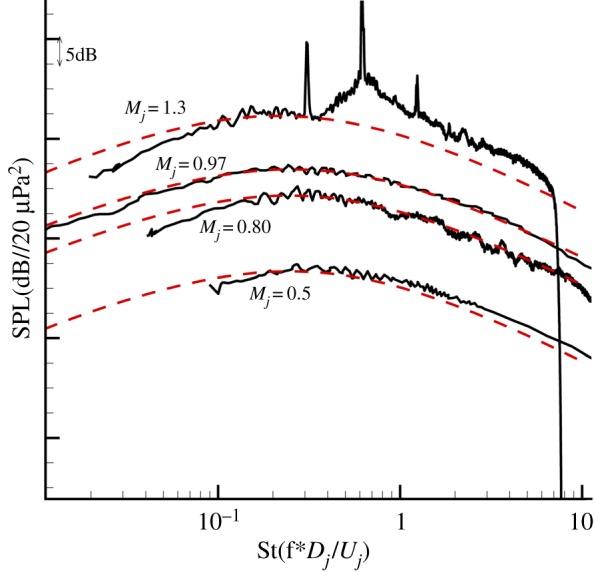
Comparison of spectra at 90° to the jet axis and R = 100D. (Online version in colour.)